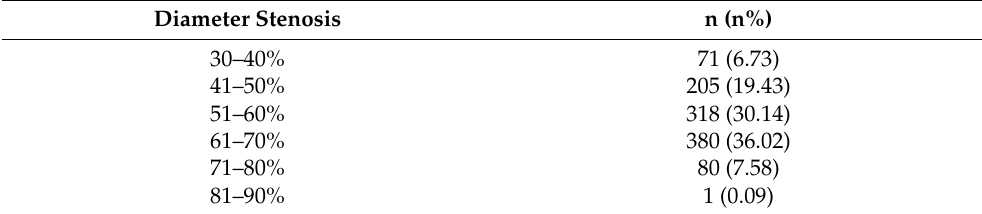
Table 2. Percent diameter stenosis of coronary stenotic lesions underwent FFR